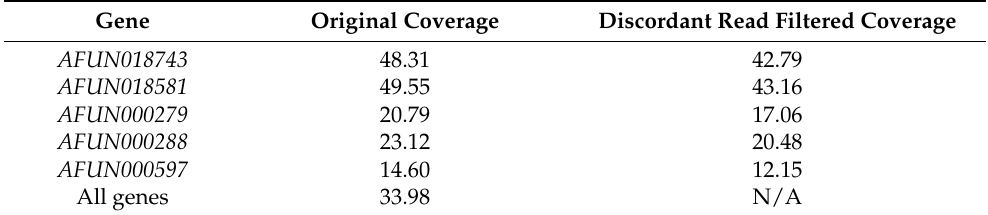
Table 2. Average gene coverages from combined PoolSeq data versus background genome-wide averages for APL1 and its